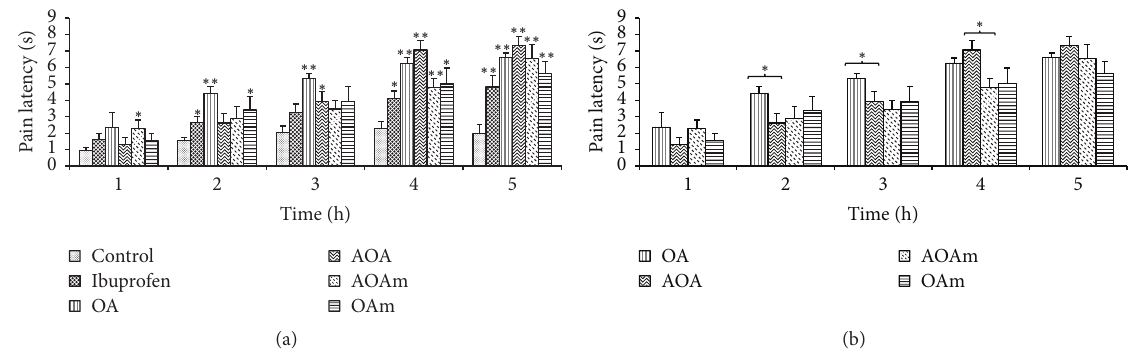
Figure 2: Analgesic effect of OA and its acetyl derivatives on tail flick response induced by radiant heat. OA (oleanolic acid), AOA (3- acetyloleanolic acid), AOAm (28-methylester, 3-acetyloleanane), and OAm (28-methyloleanane). Values are presented as mean reaction time in seconds ± SEM for 6 animals; ∗ 𝑝 < 0.05 and ∗∗ 𝑝 < 0.01 . (a) shows a comparison of the tested compounds with control group, whereas (b) shows comparison of the OA with acetyl derivatives of